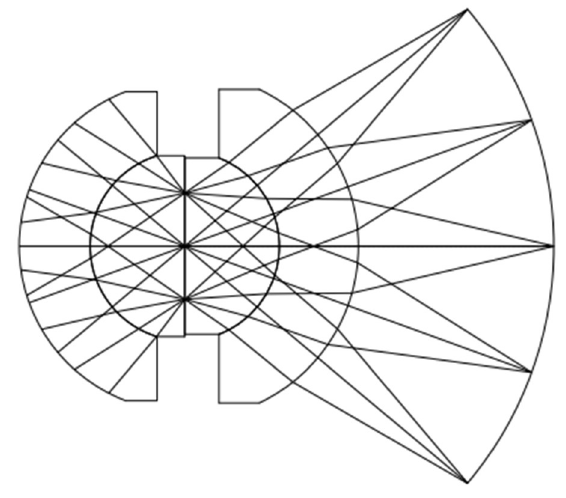
Figure 1. Diagram of the monocentric lens with ray traces.